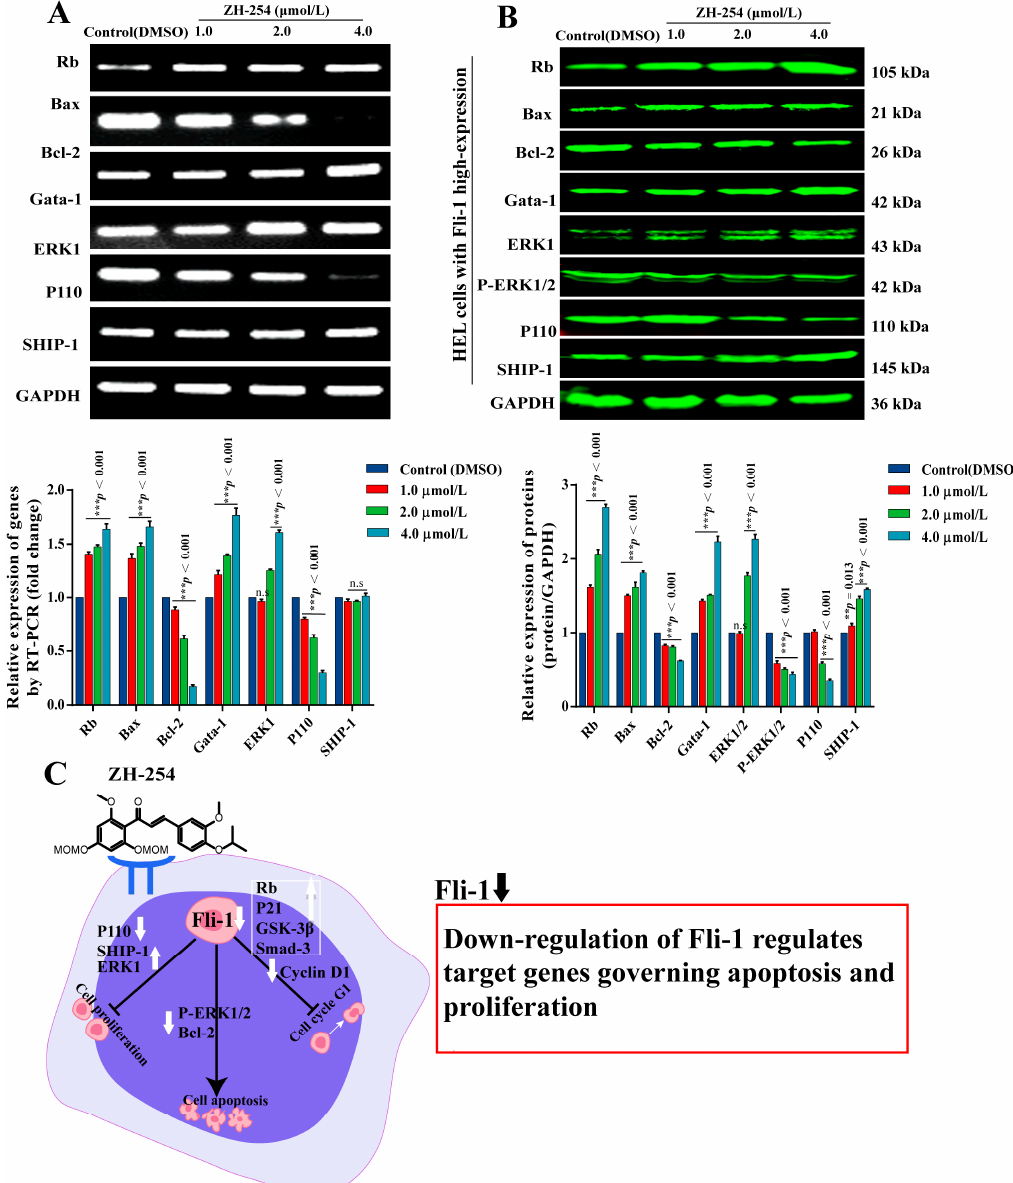
Figure 6. Regulation of Fli-1 target gene expression in HEL cells by ZH-254. The regulation of Fli-1 target genes by ZH-254 was verified by RT-PCR ( A ) and Western blotting ( B ). Image J (V1.8.0.112, NIH, Bethesda, MD USA) was used to quantify these effects. ( C ) A proposed signaling pathway suggests that ZH-254 causes apoptosis inhibits proliferation, and arrests cell cycle progression in HEL cells. *** p < 0.001is the threshold value used to consider the statistical